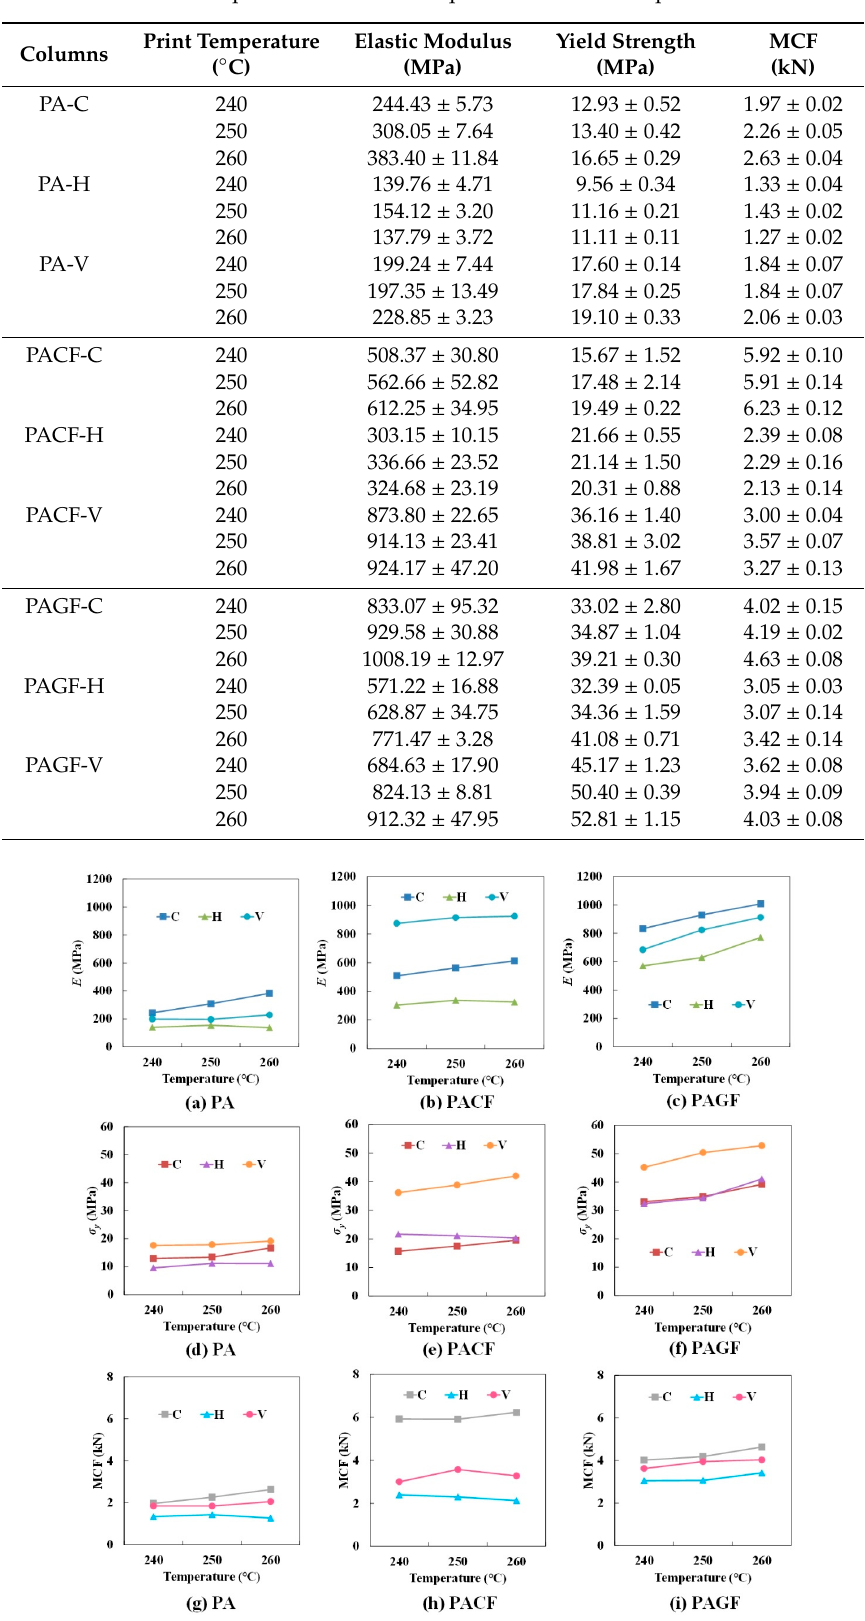
Table 2. Experimental results of quasi-static axial compression.